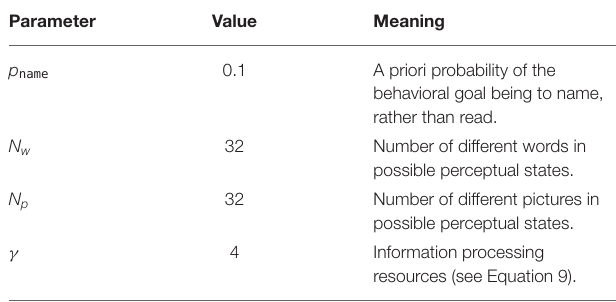
TABLE 1 | Default parameters of the simulation of the Stroop